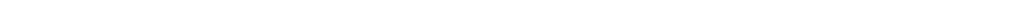
TLR2 only binds to the GAR/RGG motif on NCL. We then asked whether synthetic GAR/RGG peptides would